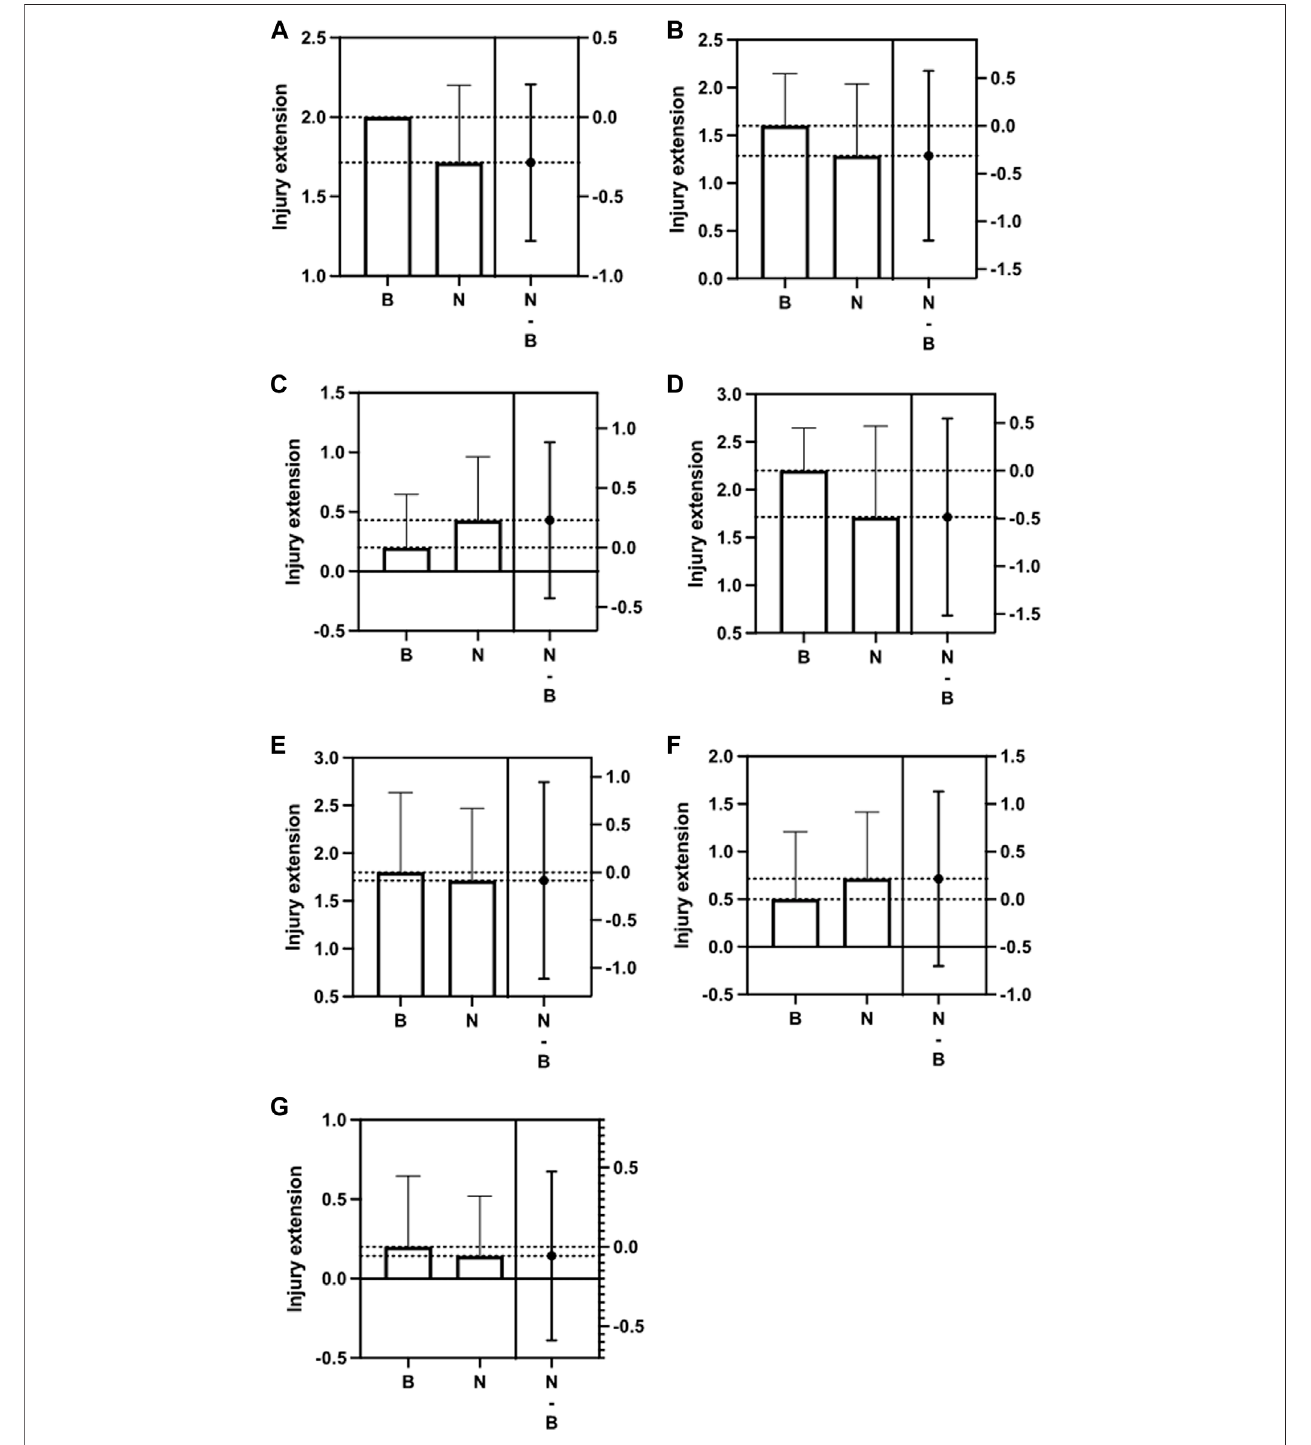
FIGURE 1 | Difference between the Control group (B) and the Nucleocapsid group (N) in relation to Epididymis in fl ammation and epithelial atrophy (A,B) ; Prostate in fl ammation and epithelial atrophy (C,D) ; Seminal vesicle epithelial atrophy (E) ; Testis in fl ammation and Leydig cell (F,G) ; The second column indicates the difference between the means ( p > 0.05).